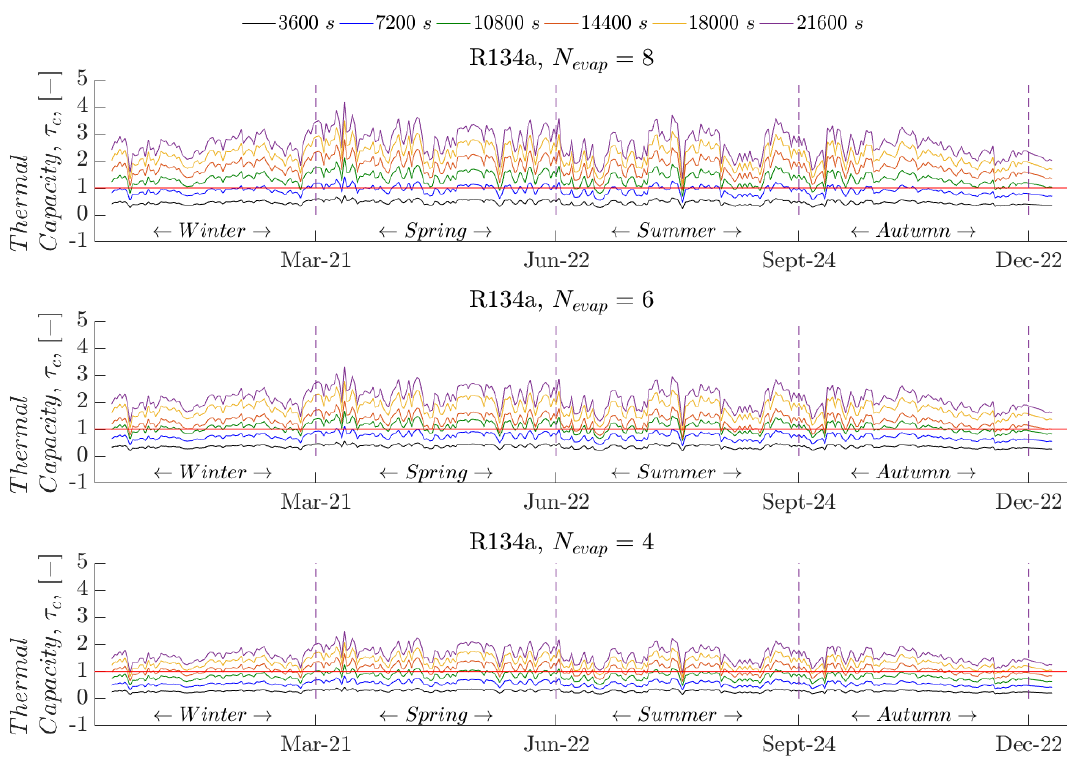
Figure 3. Thermal capacity of the heat pump during the year using R134a as working fluid.